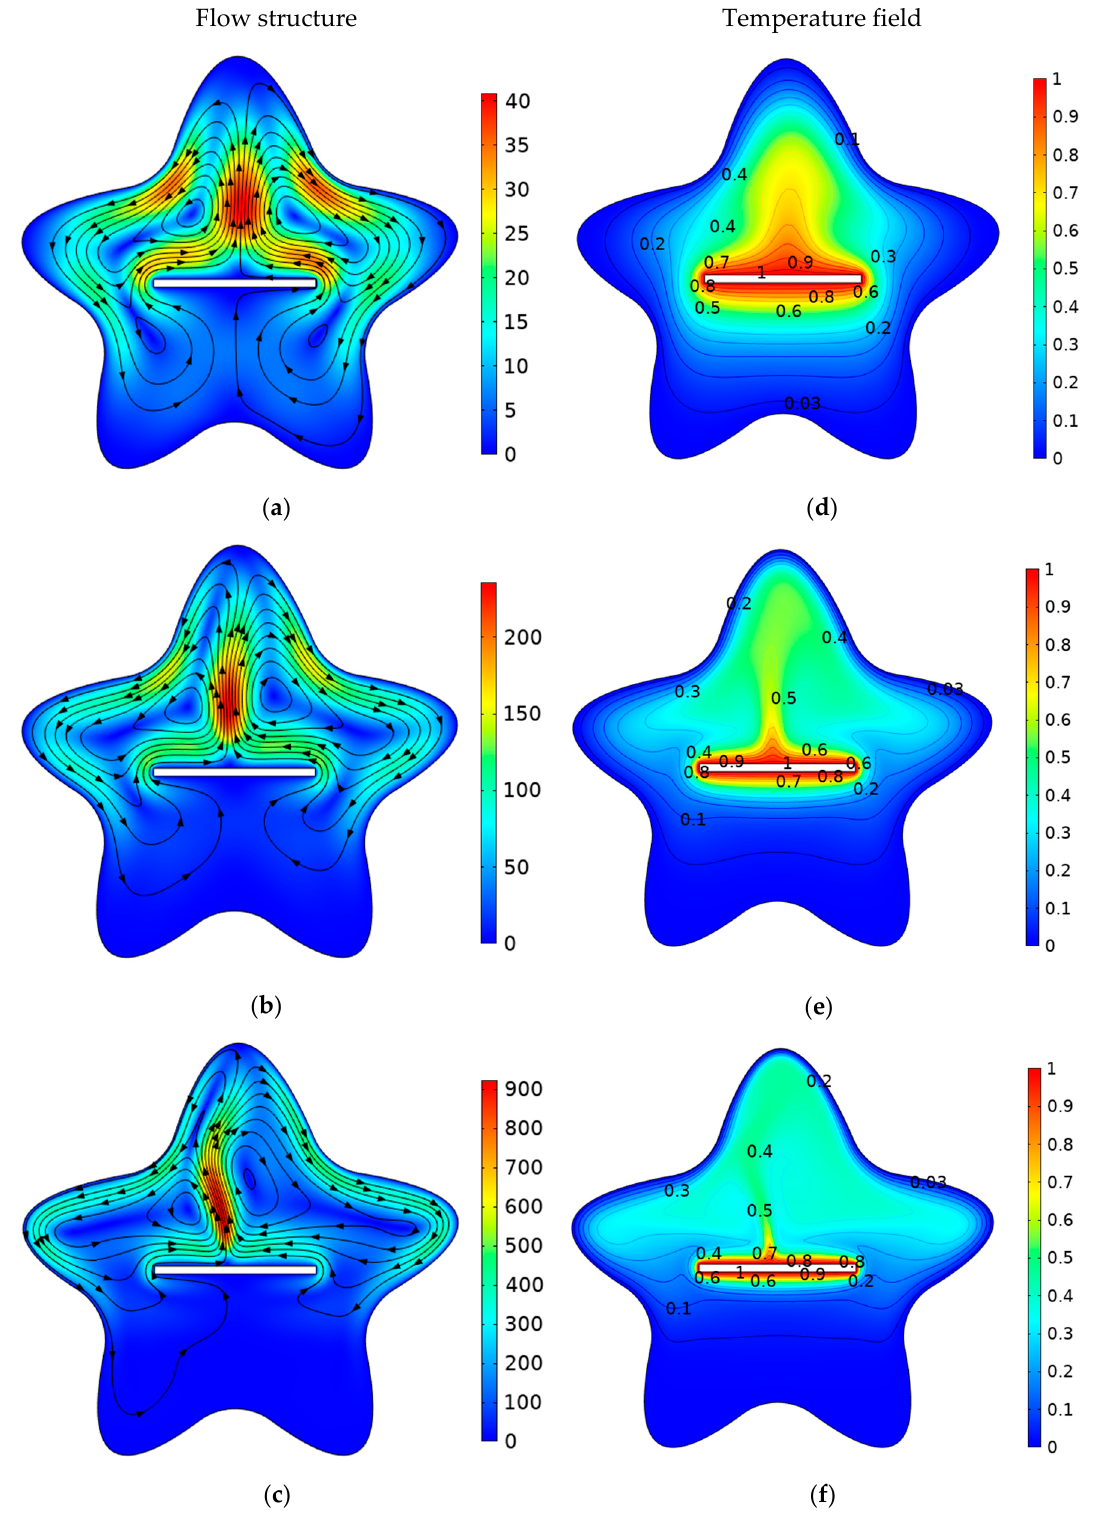
Figure 4. Flow structures ( a – c ) and temperature fields ( d – f ) for Ha = 25, φ = 0.04, and various Rayleigh number ( Ra ) values. ( a ) Ra = 10 4 ; ( b ) Ra = 10 5 ; ( c ) Ra = 10 6 ; ( d ) Ra = 10 4 ; ( e ) Ra = 10 5 ; ( f ) Ra = 10 6 .